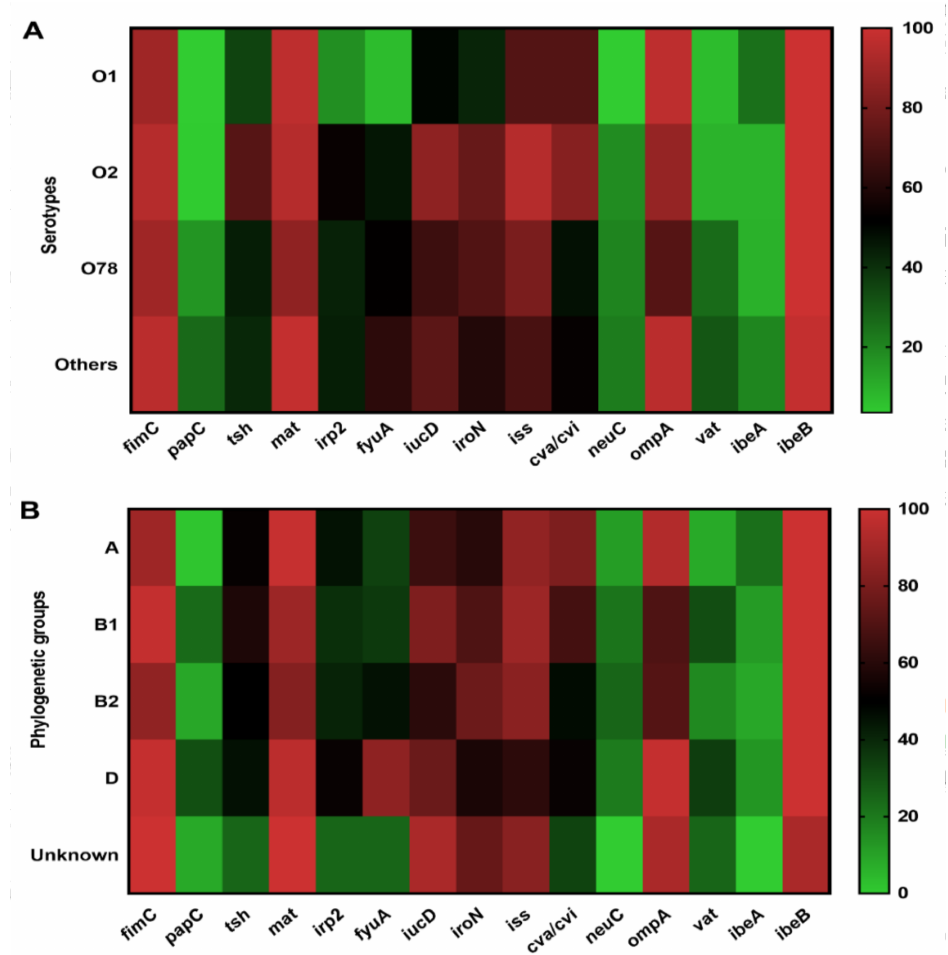
Figure 4. The prevalence of the virulence genes distribution to serotypes and phylogenetic groups (negative, weak, moderate, and strong) among APEC isolates. ( A ) Prevalence of the virulence genes distribution and the serotypes. ( B ) Prevalence of the virulence genes distribution and the serotypes and the phylogenetic